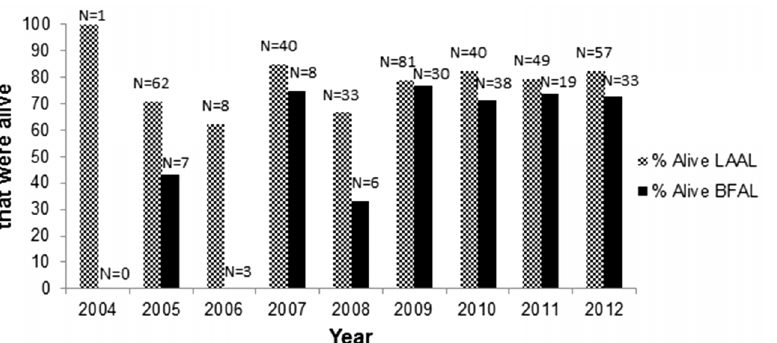
Figure 1. Percent of annual observed captures of Laysan (LAAL) and black-footed albatrosses (BFAL) that were alive at retrieval, Hawaii longline swordfish fishery, 2004–2012. Data labels are total number of LAAL or BFAL observed captured in that year.